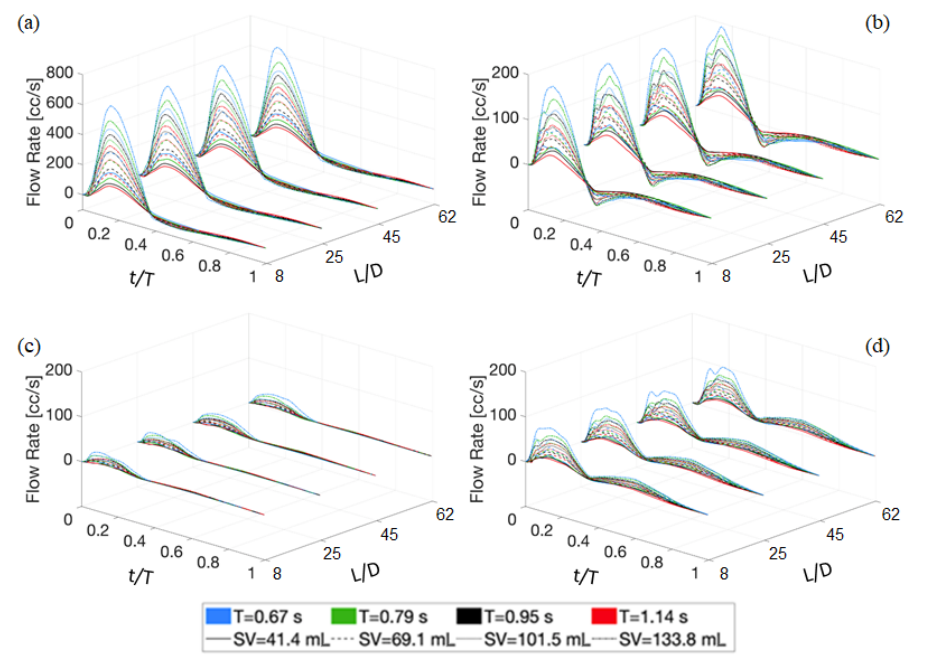
Figure 11. Effect of SV , T , and L / D on the deterministic waveforms of the flow rate at the four outlets of the coarctated aorta: ( a ) DA, ( b ) BCA, ( c ) LCCA, and ( d )